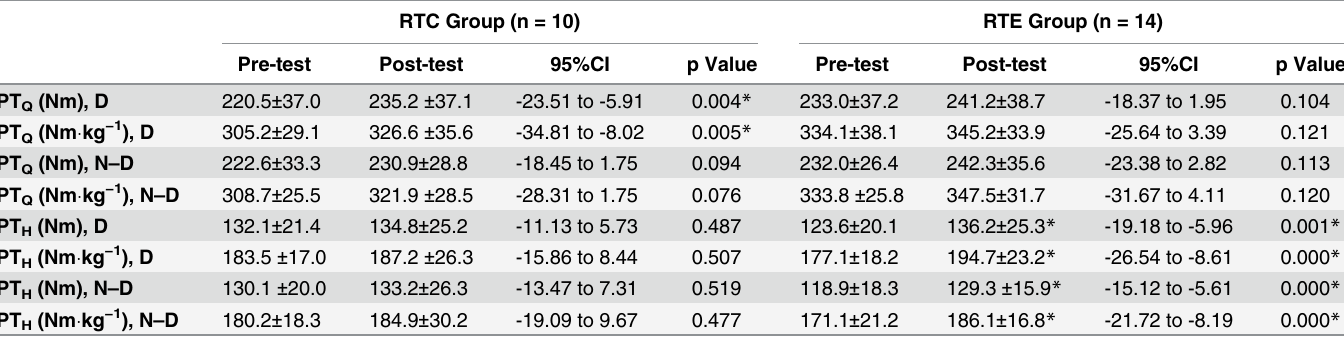
Table 4. Isokinetic peak torque (PT) [values are mean ( ± SD)], and percentage of change ( Δ ) [values are mean (95% CI)] from pre- to post-tests. RTC Group (n = 10) RTE Group (n = 14) Pre-test